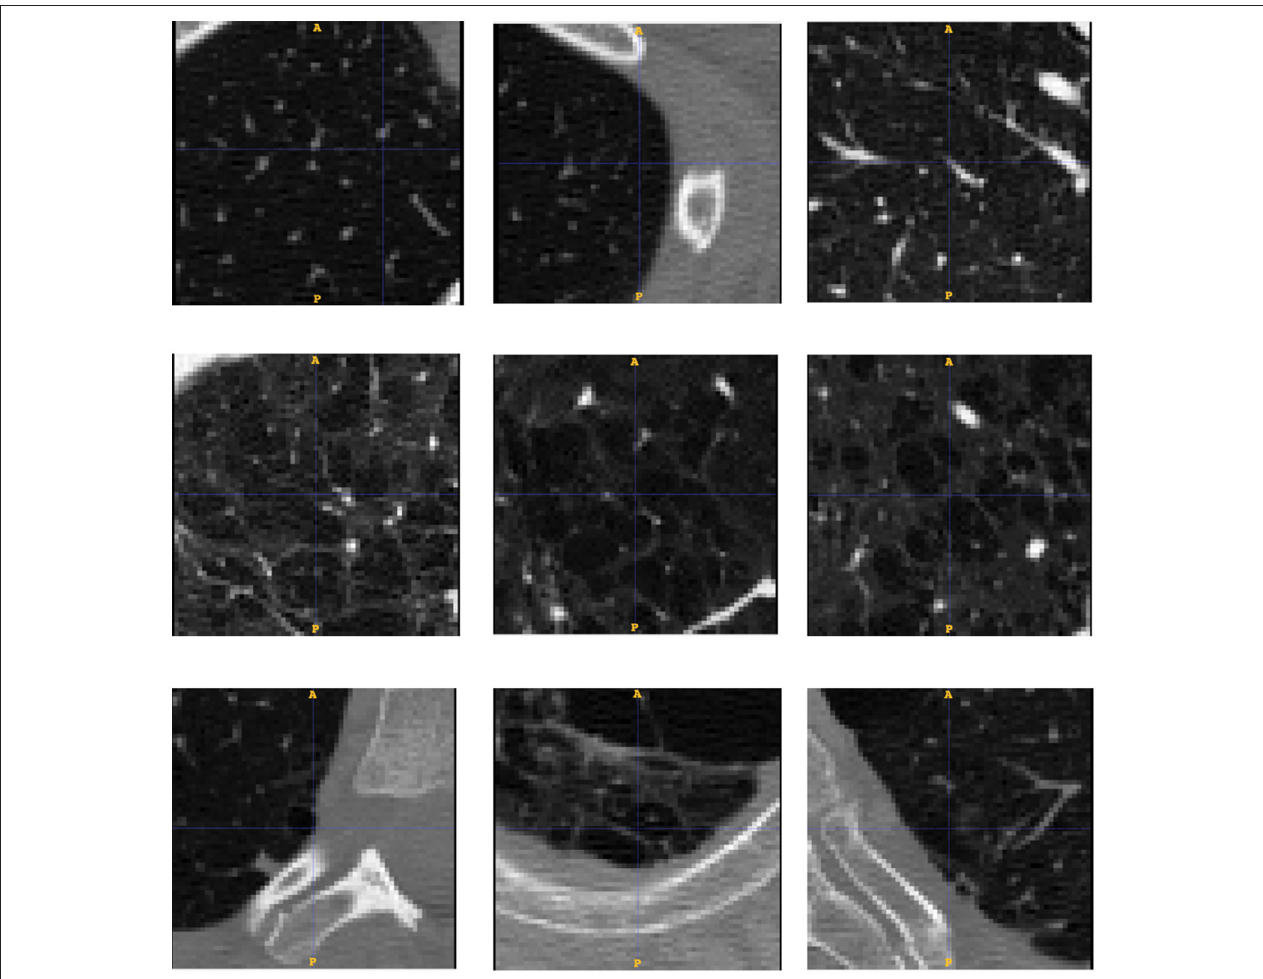
FIGURE 6 | Database patches samples for the three categories of low (up) , medium (middle) and severe (down) emphysema affectation. We see how the affectation is related to the appearance of bigger cluster of low attenuation areas from top to